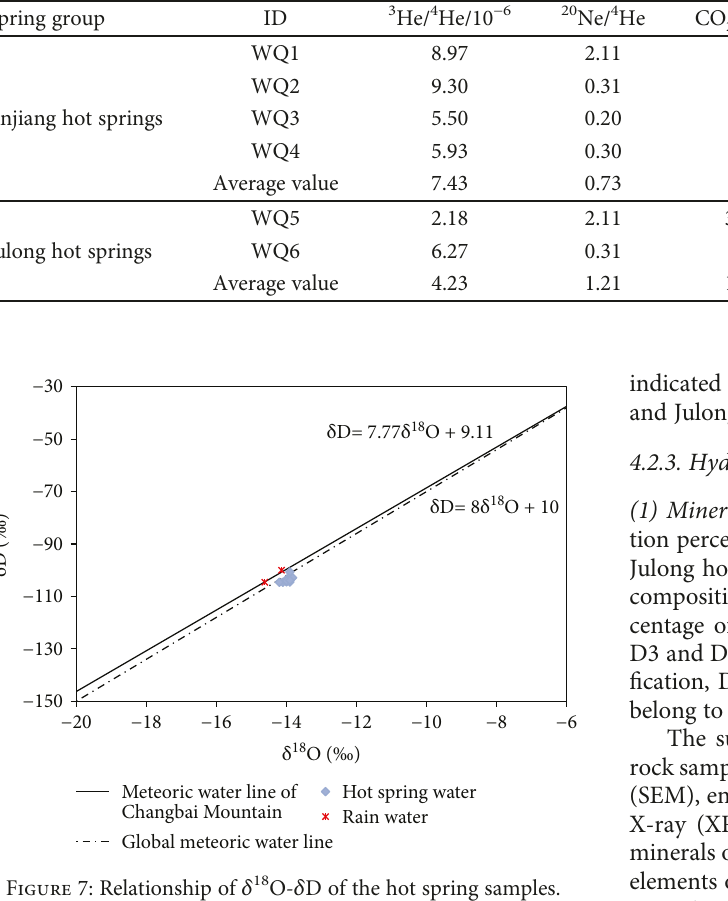
values. The δ 13 CO −